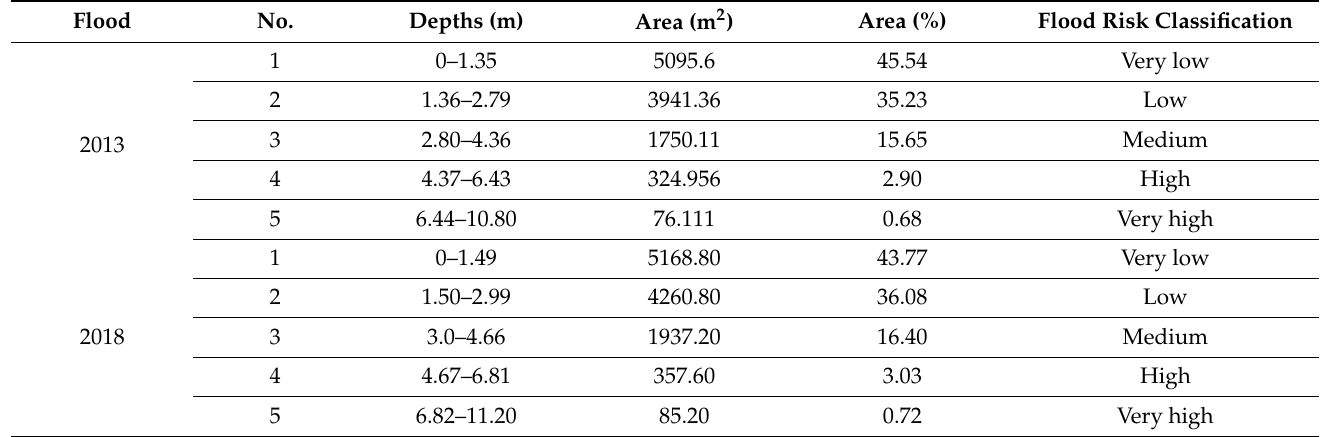
Table 12. Flood risk